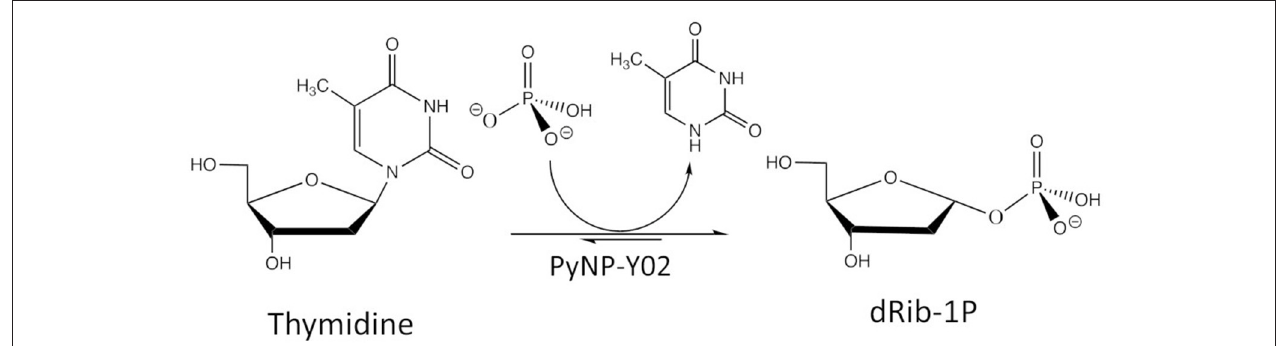
FIGURE 4 | Reaction scheme of the biocatalytic